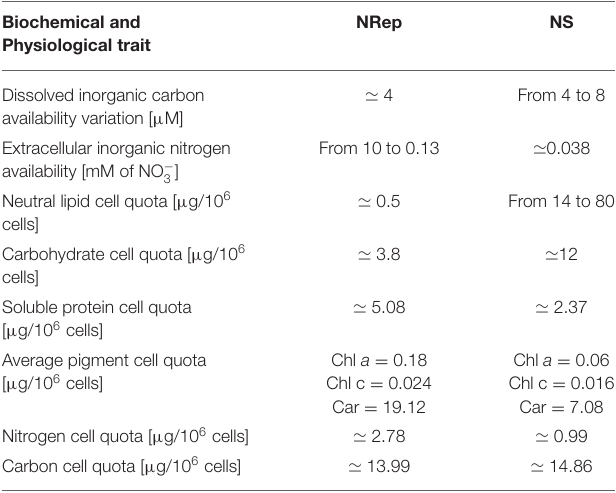
TABLE 2 | Summarizing table presenting the culture parameters during the NRep and NS phases. Biochemical and Physiological trait